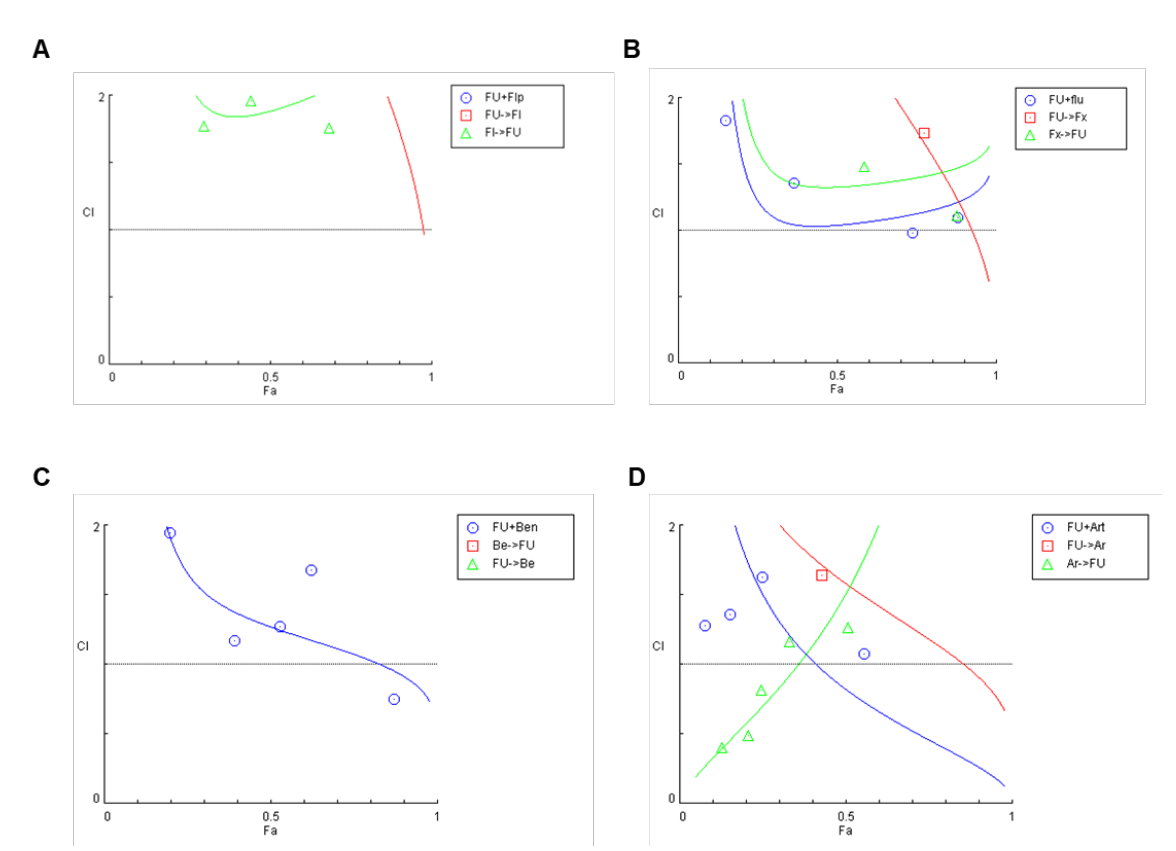
Figure 13. Chou-Talalay method Fa-CI plot of three schedule-dependent combinations of 5-FU plus fluphenazine ( A ), fluoxetine ( B ), benztropine ( C ) and artesunate ( D ). CI was plotted on the y -axis as a function of effect level (Fa) on the x -axis to evaluate drug synergism. CI < 1, CI = 1 and CI > 1 refers to synergism, additivity and antagonism, respectively. Table 4. CI values and respective fractional effect for three different combination schedules of 5-FU plus fluphenazine, fluoxetine, benztropine and artesunate. CI in red indicates concentrations of drug pairs that are synergic.